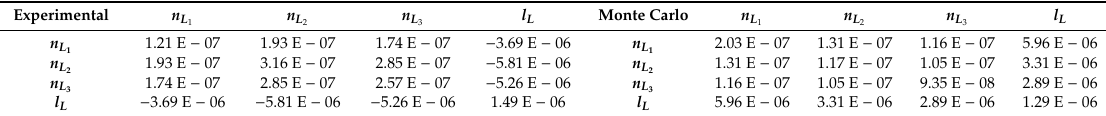
Table 7. Comparison between experimental and Monte Carlo covariance matrices (3D: 20 µ m; image: 0.1